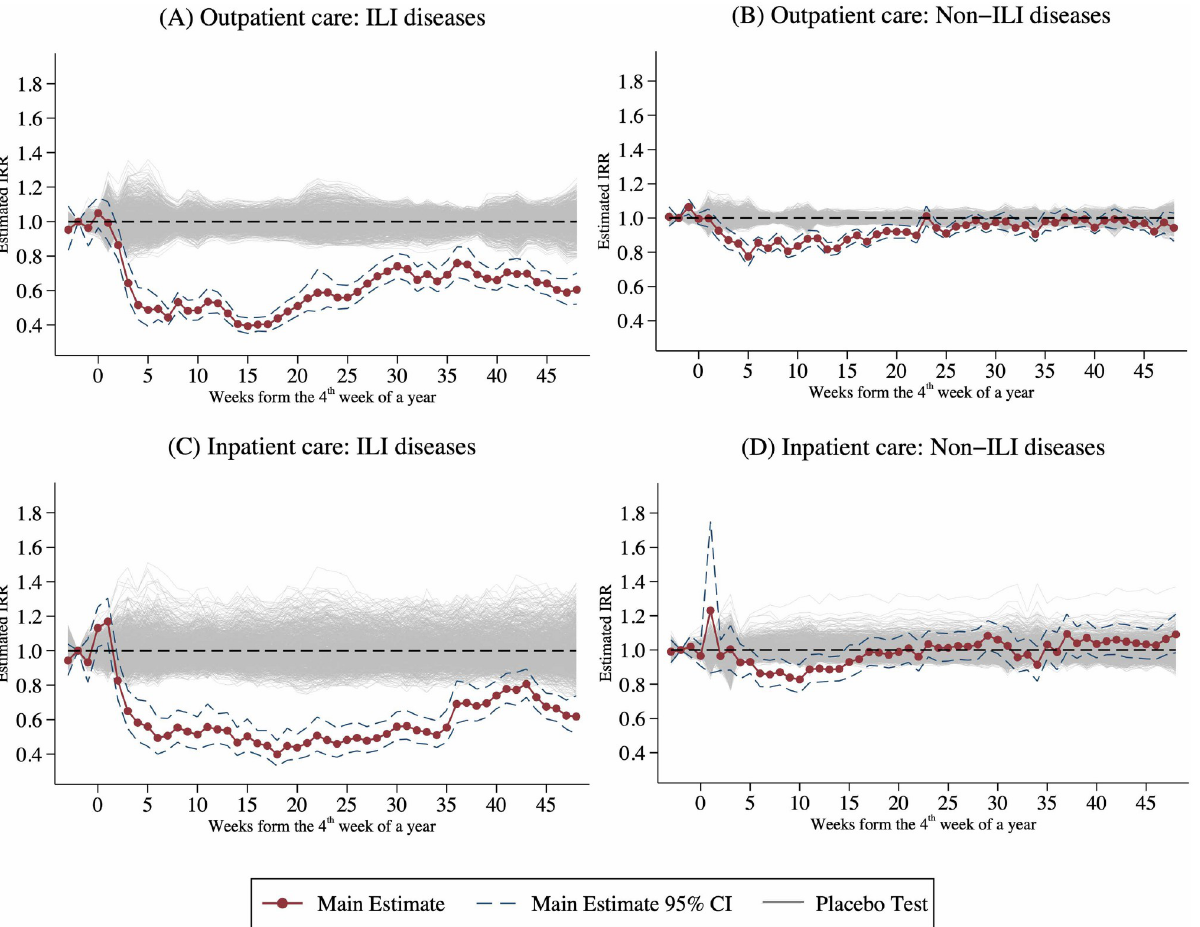
Fig 6. Placebo test: Event-study design. A: Outpatient care: ILI diseases. B: Outpatient care: Non-ILI diseases. C: Inpatient care: ILI diseases. D: Inpatient care: Non-ILI diseases. We use the 2014–2019 sample and randomly select one year as the pseudo “treated year” in each county and estimate Eq (3). We repeat the above procedures 1,000 times to obtain the distribution of placebo estimates. This figure compares our real estimates with these placebo estimates. The gray lines denote the placebo estimates, and the red dots and blue dashed lines denote the real estimates and the corresponding 95% confidence